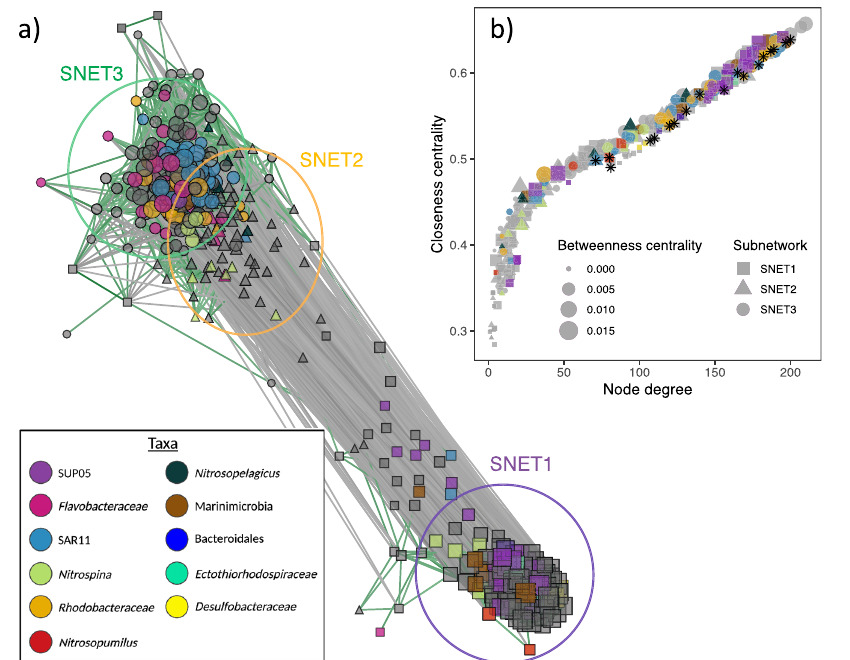
Fig. 3 Co-occurrence network depicting interactions between bacterial and archaeal ASVs in the Saanich Inlet microbiome. In panel a gray lines depict negative covariance and green lines depict positive covariance with ρ > |0.60|. Node size represents intranetwork connectivity (K in ) and shapes indicate subnetwork assignments determined by WGCNA. Squares, triangles, and circles represent taxa belonging to SNET1, SNET2, and SNET3, respectively, and are highlighted by colored circles. Taxonomic assignments are represented by colored nodes. Panel b depicts relationships between node (ASV) degree, closeness centrality, and betweenness centrality determined through analysis of the propr network. Individual ASVs implicated by sPLSR (Fig. 5) as important predictors of rate processes and Δ N 2 O are indicated (*) in panel ( b ). Table 1 Pairwise correlations between subnetwork (SNET) eigengenes and sample traits. Environmental variables